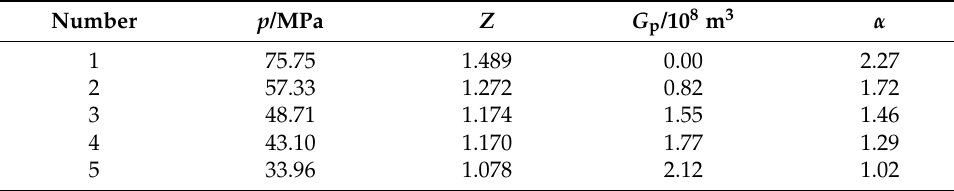
Table A5. Historical production data of the Miocene S. Louis reservoir